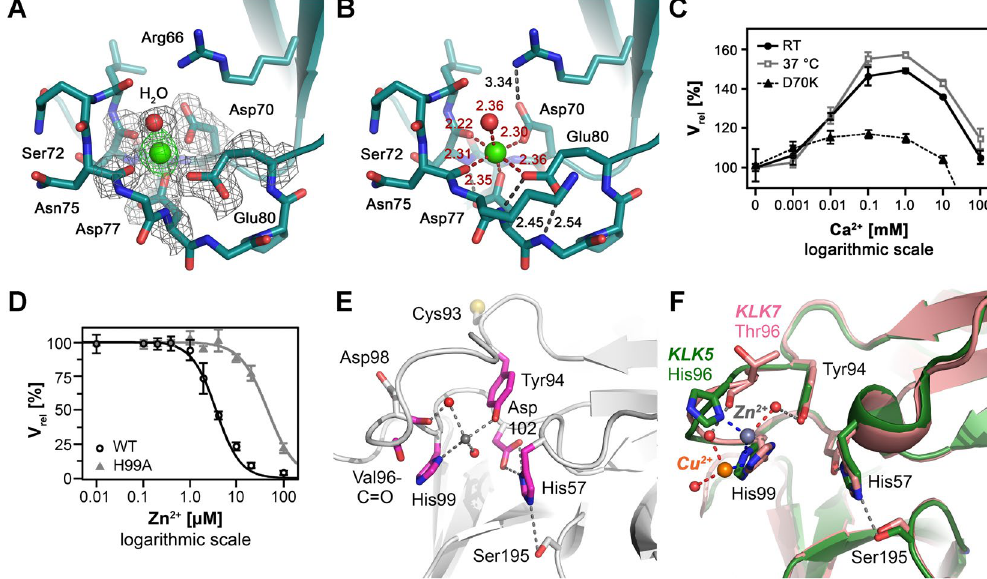
Figure 4. The Ca 2 + and Zn 2 + binding loops of KLK8 as regulatory modules. (A ) The 75-loop of KLK8-Ca with Ca 2 + ligands surrounded by the 2F o -F c electron density map, contoured at 1.0 σ . Ca 2 + is depicted in green with electron density contoured at 3.0 σ , while the water ligand is shown as red sphere. ( B ) Ligand bonds to Ca 2 + are shown as red dots and relevant hydrogen bonds as black dots, including distances in Å. The excess charge of three carboxylates is compensated by Arg66 near Asp70 and hydrogen bonds of Asp77 and Glu80 with backbone N-H groups. ( C ) The Ca 2 + stimulation of the KLK8 activity is maximal in the range 100 µ M to about 1 mM. In the D70K variant no significant stimulatory effect of Ca 2 + was observed. ( D ) The mutant His99Ala confirmed the inhibitory Zn 2 + site with a 13-fold higher IC 50 , i.e. 47 µ M versus 3.6 µ M of wild-type KLK8. ( E ) In the 99-loop, Cys93 can be excluded as potential Zn 2 + ligand, since Zn 2 + inhibition of the Cys93Ser variant was unchanged compared to the wild-type. A water molecule (grey) between His99 and Tyr94 in KLK8- leup is in a suitable position to bind Zn 2 + . The variant Tyr94Phe has a 2-fold higher IC 50 , suggesting a minor role as Zn 2 + ligand for Tyr94. Hydrogen bonds are shown as grey dots. ( F ) Two complex structures of KLK5 and KLK7 with Zn 2 + and Cu 2 + feature ligands for cations, such as the carbonyl O of residue 96 and Tyr94. The KLK7-His99Ala mutant nearly abolished the non-competitive Zn 2 + inhibition, as for KLK8. This inhibition type can be explained by Zn 2 + binding to the His57 side chain, which has to switch from the catalytic triad. A rotation of His99 would bring both ligands in ideal distances to Zn 2 + 36